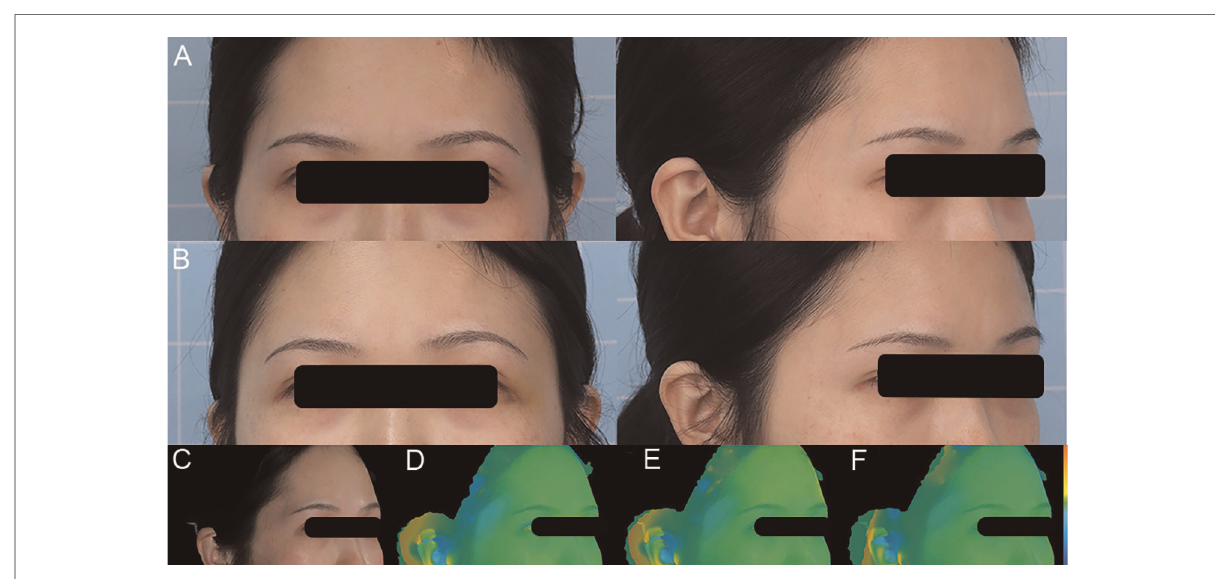
FIGURE 5 A 28-year-old female patient presented with temporal hollowness and a prominent tear trough deformity and was treated with one SVF-gel grafting procedure. ( A ) Preoperative front and right oblique photos. ( B ) Preoperative front and right oblique photos at 12 months. ( C ) Preoperative right oblique photo. ( D – F ) 3D reconstruction of right oblique images at 1, 6, and 12